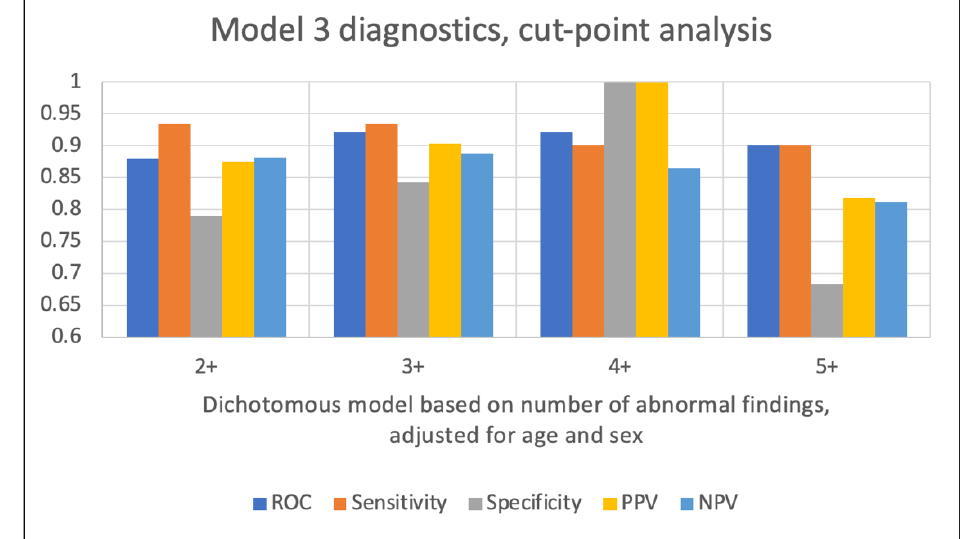
Figure 5. Diagnostic accuracy results for Model 3.